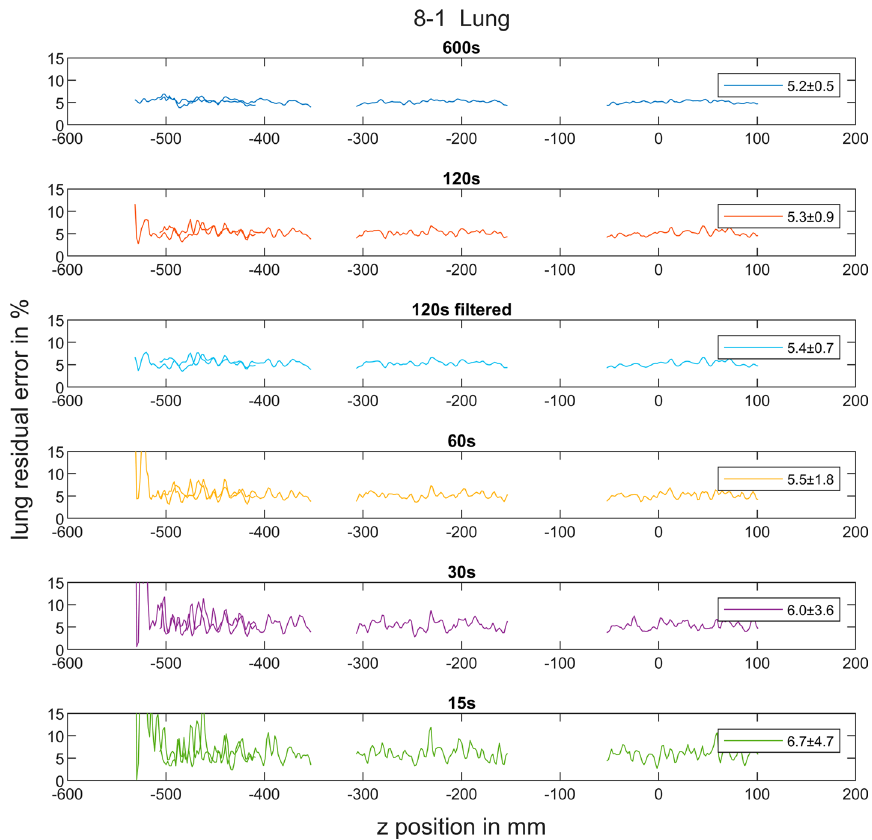
Fig. 4 Axial variation of the lung residual error [%] including an example of a filtered data set (120 s with 3 mm FWHM Gaussian filter). The mean and SD of the lung residual error are given in the legend of the respective